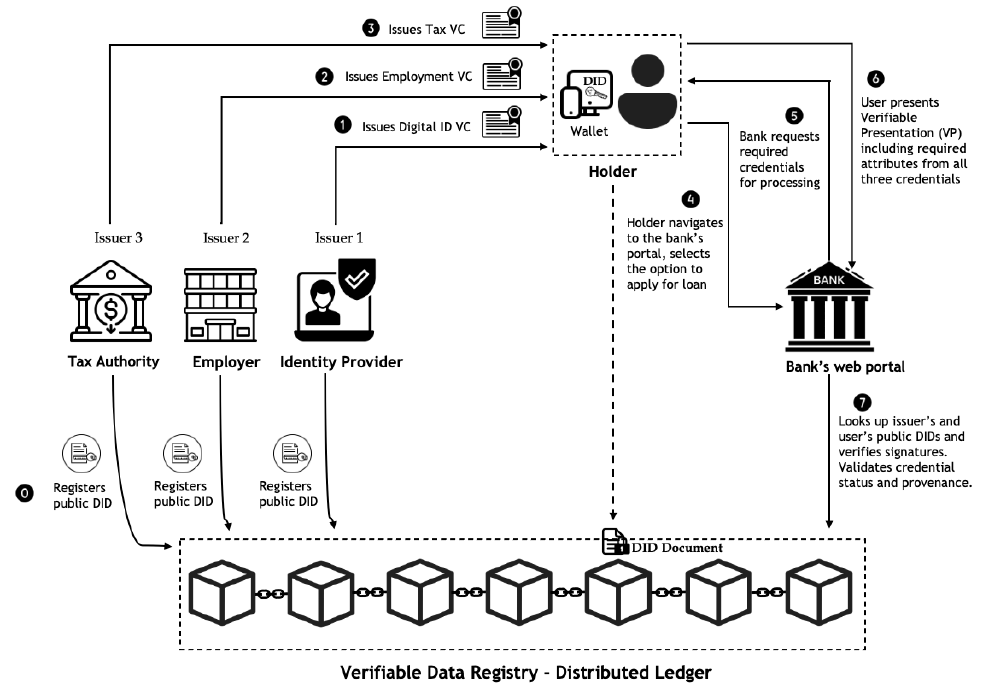
Figure 3. Architecture of the proposed